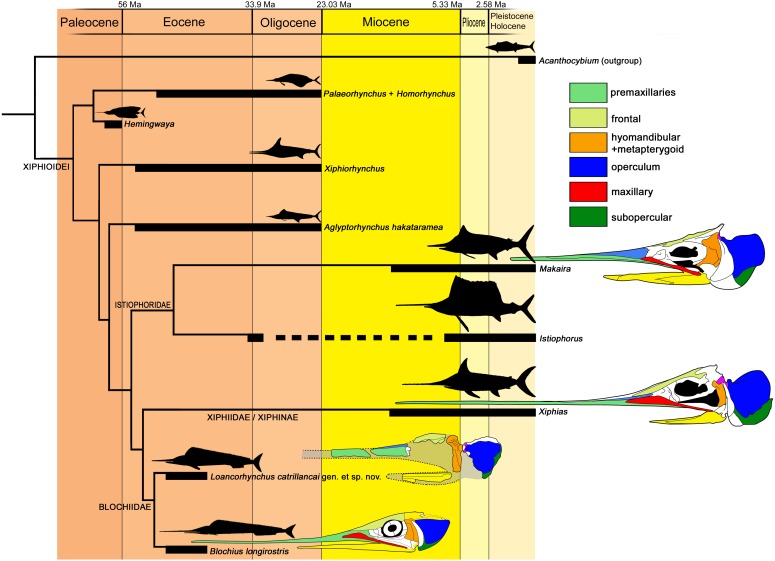
Cladogram of the Xiphioidei, including Loancorhynchus catrillancai gen. et sp. nov.Cladogram is based on the phylogenetic analysis performed here (Single MPC; CI = 0.750; RI = 0.600; Implied Weighting (K −  = 3); New Technology Search; Ratchet. Pruned taxa: ‘Blochius’ moorheadi, Cylindracanthus, Hemirhabdorhynchus and Pseudotetrapturus luteus). Biochrons are based on Fierstine (2006). Body outlines are based in Nakamura (1985). Skull schemes based in Gregory & Conrad (1937) and Fierstine & Monsch (2002). Dorsal longitudinal ridges on the rostrum (Char. 7) supports Loancorhynchus catrillancai within the Blochidae. Villiform teeth in the rostrum and dentary (Char. 27). separates L. catrillancai from Blochius longirostris and Blochius macropterus.